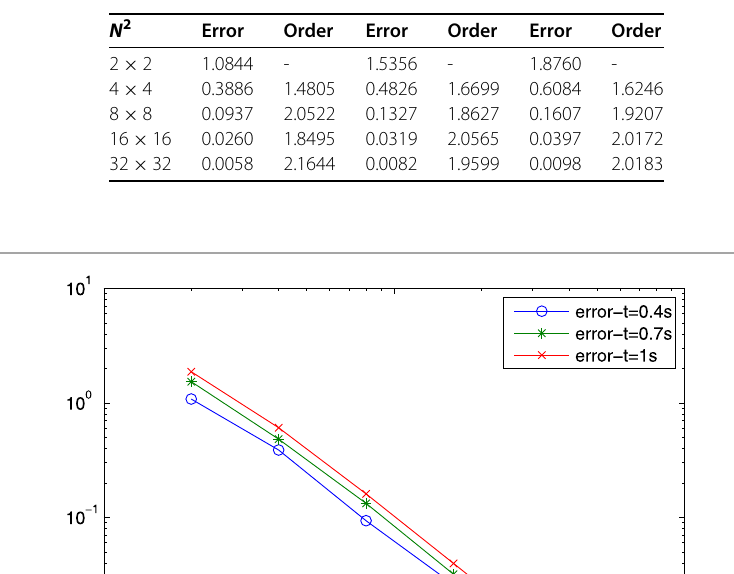
Figure 1 The error estimate at t =0.4, 0.7s and 1s.